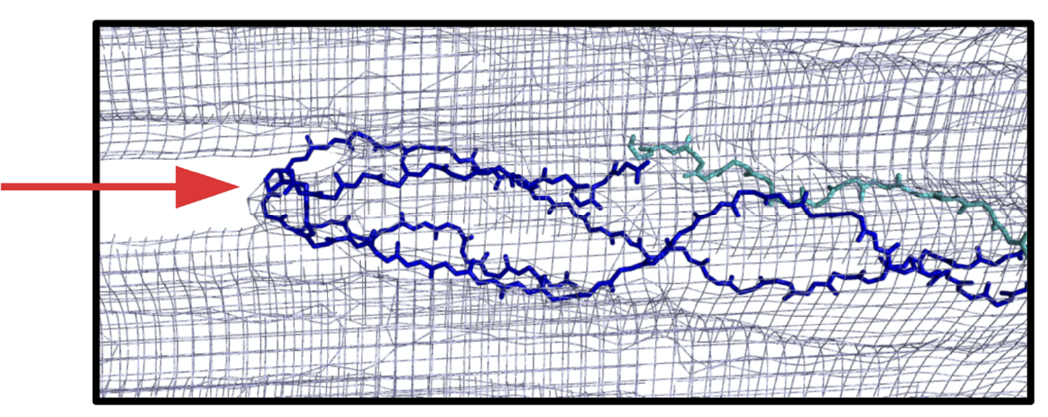
Figure 7. X-ray diffraction model of the C-terminal telopeptide region of the rat type I collagen microfibril. The truncated α 2(I) chain is shown in cyan (see text). The electron density defining the C-terminal region is seen to terminate at the ends of the C-telopeptides, where the α 1(I) chains, in dark blue, fold back on themselves. The anti-fibrotic antibody binding sequence on human collagen—the α 2Ct epitope—can be accommodated within the limits of the C-terminus of the rat protein, however the homologous sequence on the rat α 2(I) chain is not found in the structural electron density model (gray wireframe, C-terminal electron density indicated; red arrow). To enable molecular modeling of scFv antibody-collagen interactions with rat collagen, the α 2(I) chain of the rat protein was extended C-terminally to include the α 2Ct epitope of the rat/human sequence in the molecular model shown in Figure 8 (see text and Table